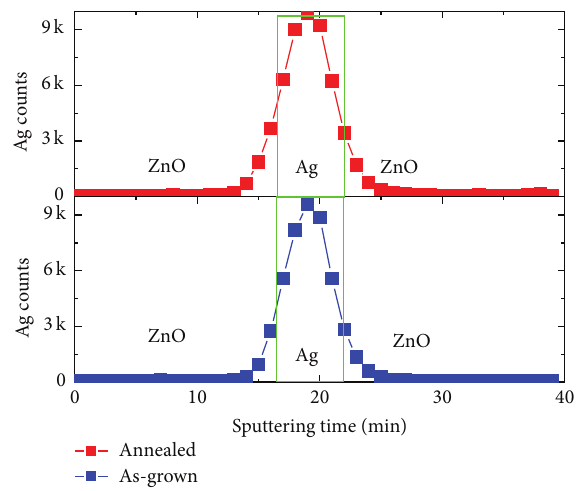
Figure 8: Depth profile of Ag species in the ZAZ multilayer as- prepared and after annealing for 400 ∘ C for 20